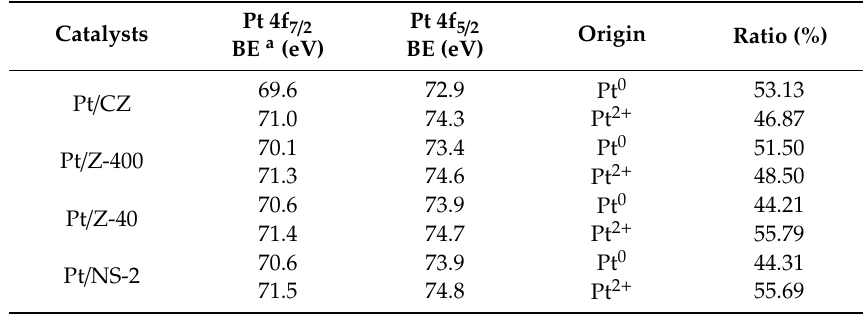
Table 3. XPS parameters of di ff erent Pt-loaded zeolite